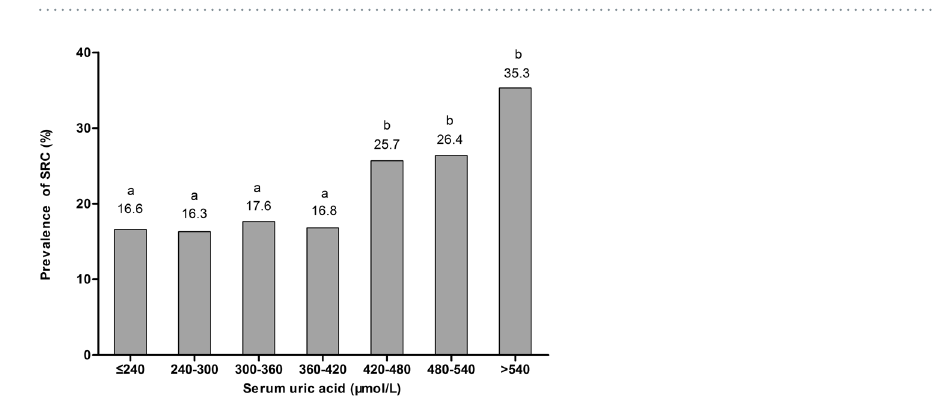
Table 2 (except serum uric acid, eGFR, and diabetic nephropathy), including hyperuricemia, age, sex, duration of diabetes, albuminuria, serum creatinine, alanine aminotransferase, aspartate aminotransferase, γ -glutamyl transferase, total cholesterol, high-density lipoprotein cholesterol, low-density lipoprotein cholesterol, fasting plasma glucose, FEUA, hypertension and urolithiasis were selected as covariates in multivariate logistic regres- sion to identify risk factors for SRC development. In males and postmenopausal females with type 2 diabetes, hyperuricemia (odds ratio [OR] 1.824, 95% confidence interval [CI] 1.332–2.498, P < 0.001); FEUA (OR 1.046,